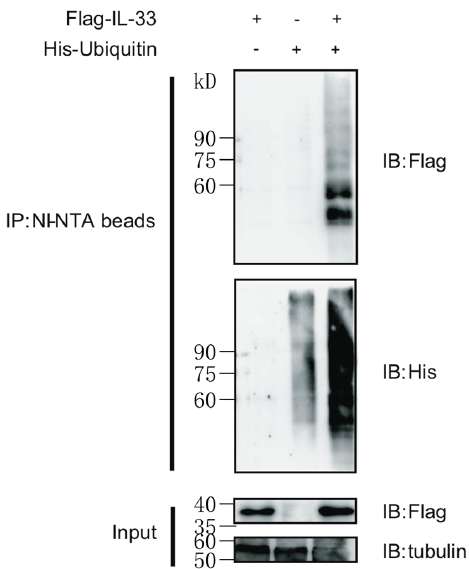
Figure 1. IL-33 can be modified by polyubiquitination. HEK293T cells were transfected with the plasmids of Flag-tagged IL-33 and/or His-tagged ubiquitin. Cells were treated with 20 nM MG132 for 4 h before harvesting. Ubiquitinated IL-33 was pulled-down with Ni-NTA beads upon denaturing conditions as described in the Materials and Methods. Immune blots (IB) were performed with indicated antibodies. Data are representative of at least three independent experiments.